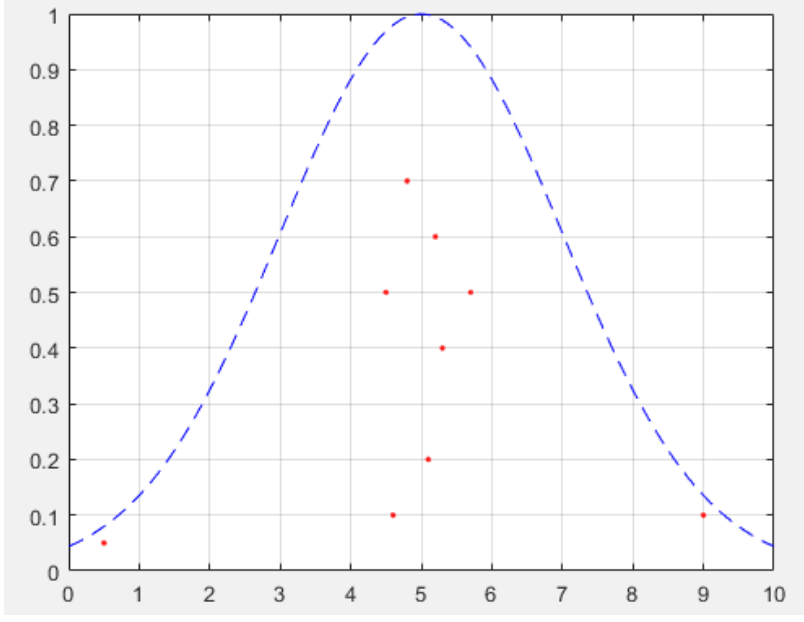
Figure 7. Schematic diagram of normal distribution